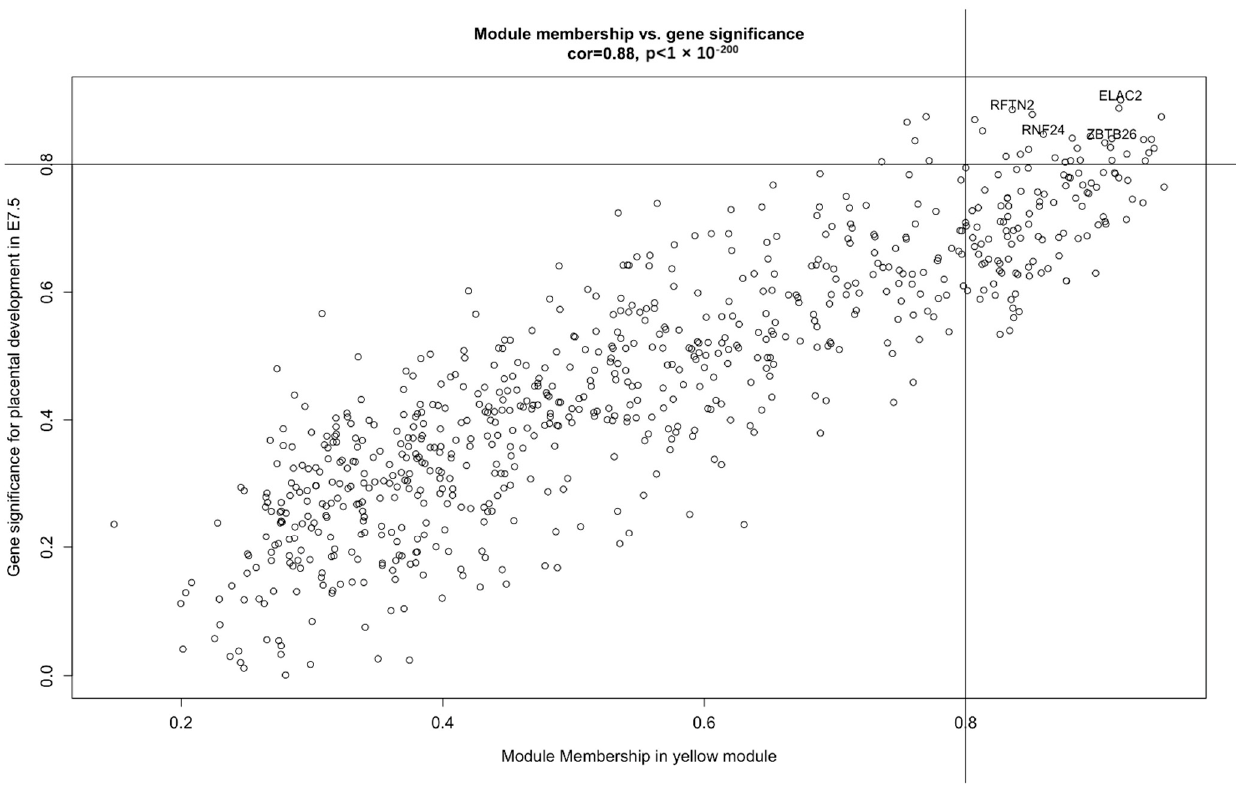
Figure 2. A scatterplot of gene significance (GS) for placental development in E7.5 vs. module member- ship (MM) in yellow module. The correlation coefficient and p value are listed above the scatter- plots.